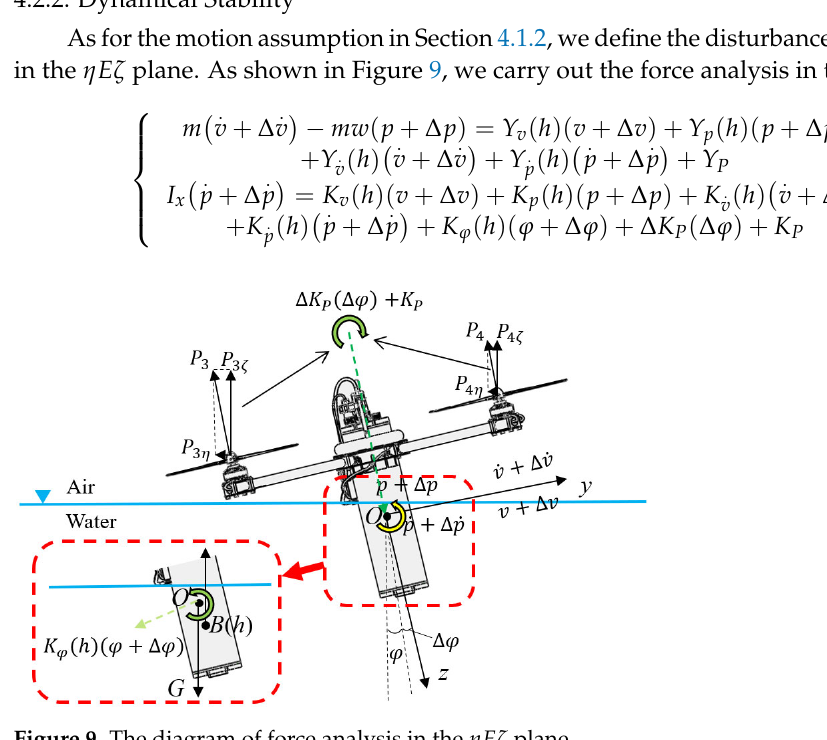
Figure 9. The diagram of force analysis in the η E ζ plane.